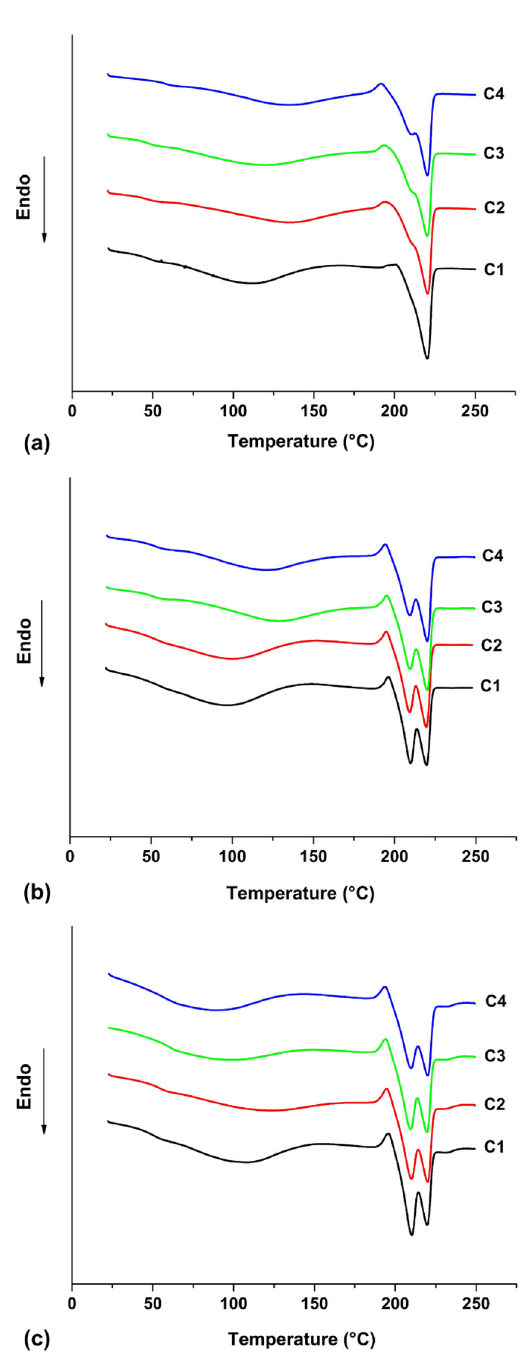
Figure 3. DSC curves of the blown films obtained in different processing conditions (C1, C2, C3 and C4): (a) PA6; (b) PA6/ MMT; (c)